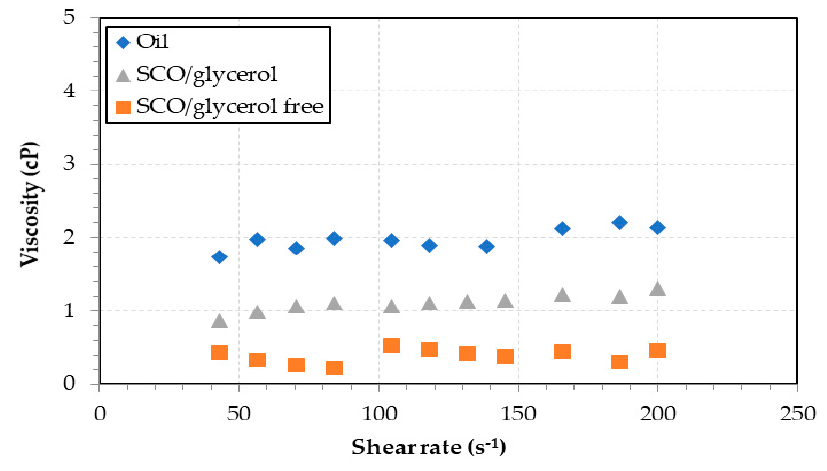
Figure 5. Viscosity of petroleum, SCO / glycerol, and SCO / glycerol free, at 55 °C .